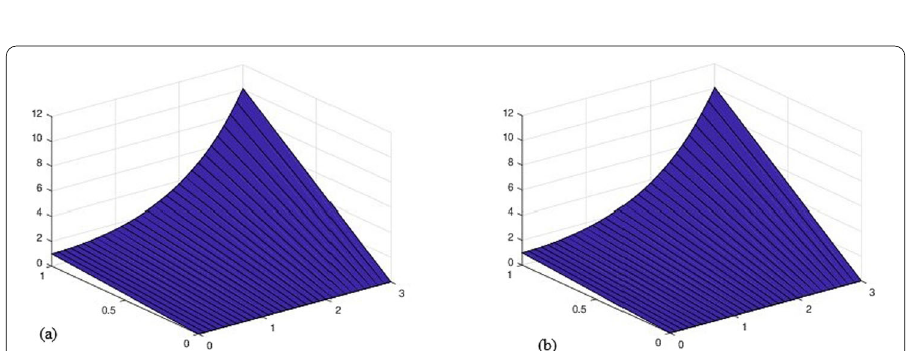
Figure 2 ( a ) Graphs of exact and ( b ) approximate solution of γ = 1 of Example 1